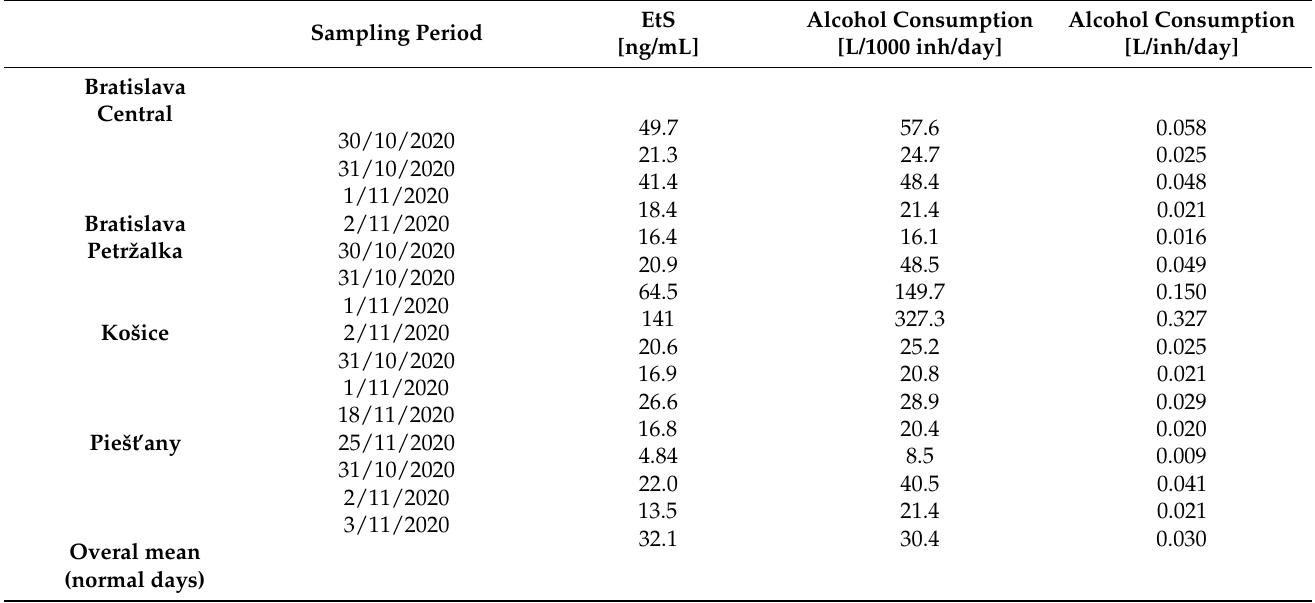
Table 2. Estimated daily consumption of alcohol in three Slovak cities during normal days in 2020.